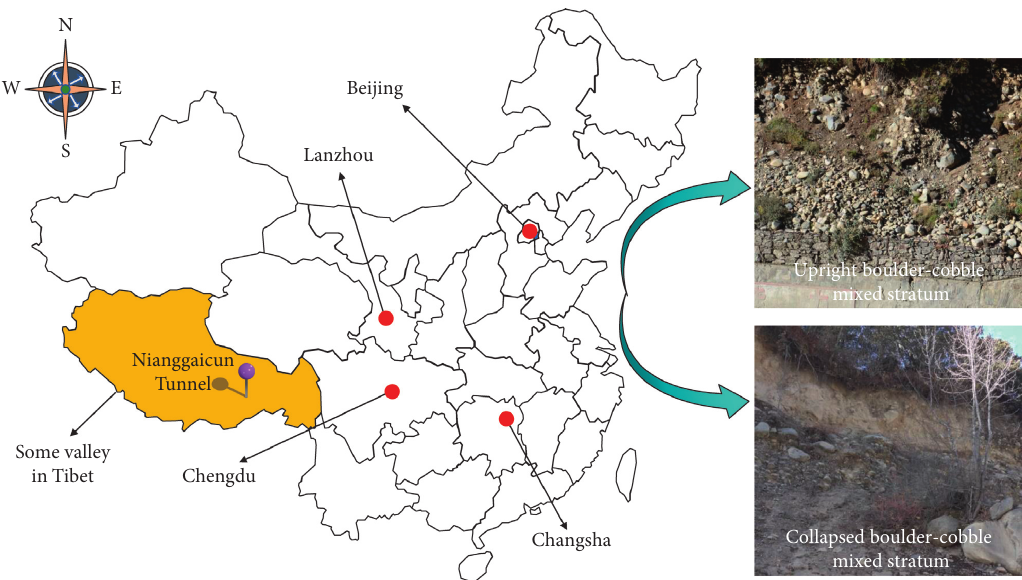
Figure 1: Distribution of boulder-cobble mixed grounds in